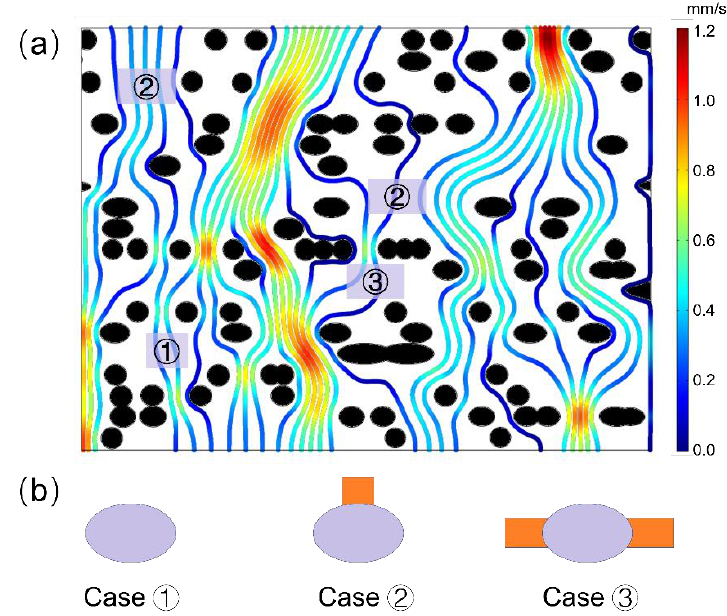
Figure 4. ( a ) Streamline diagram within intervessel pit membranes of angiosperm xylem from microfluid flow simulation. ( b ) Three typical obstructed cases with big pores hardly contribute to fluid transport, due to blockage of cellulose microfibrils in the direction across pit membrane thickness, i.e., fluid flow direction. In case 1, almost no water pathway was found around that pore, and in case 2, only one pathway was available, while in case 3, two pathways were available, however, contributing little flow rate. In Figure 4a, red color represents high flow rate while blue color represents low flow rate, and black circles represent cellulose microfibril. In Figure 4b, grey circles represent big pores while orange color represents water